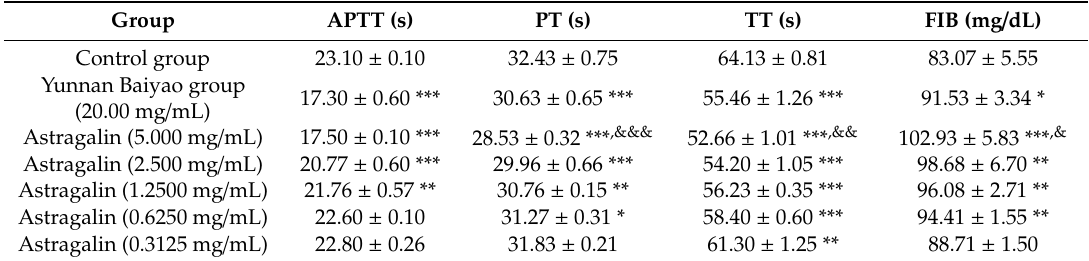
Table 2. Procoagulant activity of di ff erent concentrations of astragalin (X ± SD, n = 3).